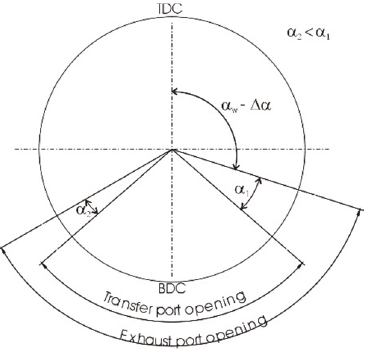
Fig. 5. Asymmetric phase timing in 2sOPE (earlier opening of exhaust ports) Theoretical cycle of diesel engine assumes that whole dose of fuel is burned at constant pressure. But the work of real diesel engines can be presented according to the Sa- bathe’s cycle, where a part of fuel is burned also at isochor- ic process. The modified Atkinson cycle for two-stroke opposed diesel engine is presented in Fig. 6 with asymmet- ric opening (p. 1) and closing (p. 5) of exhaust